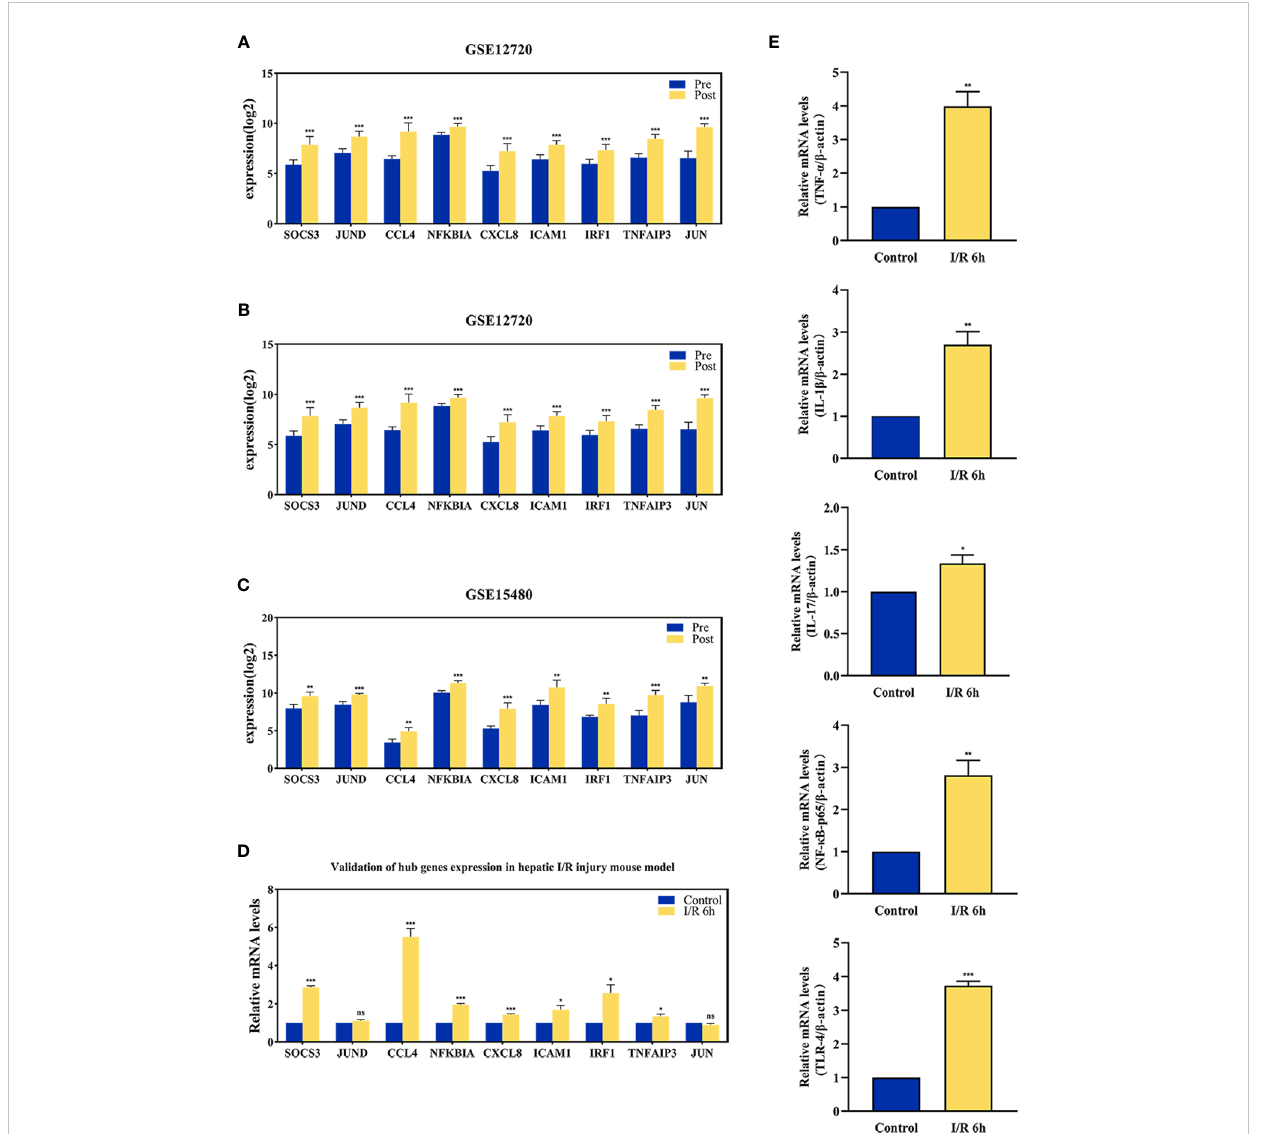
FIGURE 10 The validation of immune-related hub genes expression and innate immune signaling. The expression level of hub genes in GSE12720 (A) , GSE14951 (B) , and GSE15480 (C) . (D) The expression level of hub genes in mouse at 6 h after I/R or sham group. (E) mRNA levels of TNF- a , IL-1 b , IL-17, NF- k B-p65, and TLR-4 in mouse at 6 h after I/R or sham group. *p < 0.01; **p < 0.001; ***p < 0.0001. ns=non-signi fi